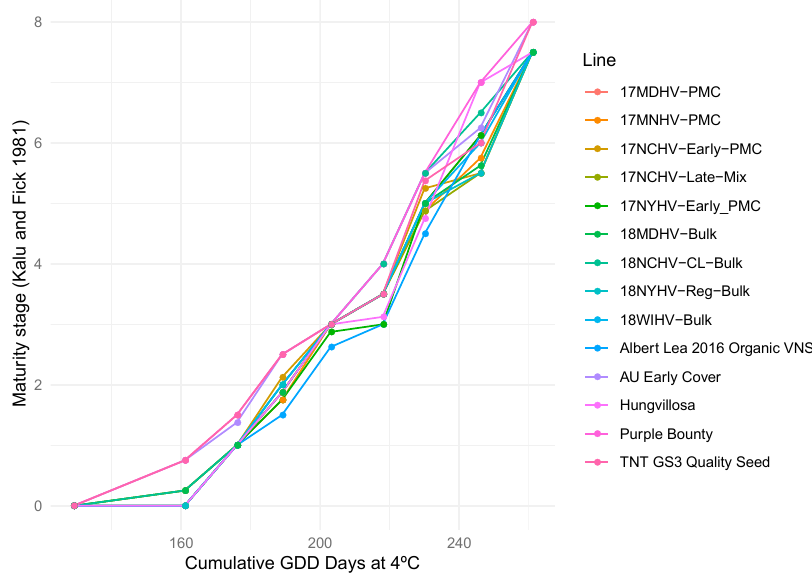
Figure A1. Maturity development time series for fourteen V. villosa lines grown at the USDA-ARS Forage Seed and Cereal Research Unit in Corvallis, Oregon in 2019. Data were collected in four replicate plots per line, each plot measuring 4.65 m 2 . Every two weeks, researchers rated the maturity of each line on a scale modified from Kalu and Fick [54]. A linear extrapolation function of the data determined the growing degree days above 4 °C (GDD) necessary to reach physiological seed maturity. In a linear model (Equation (3)), maturity stage explained 97.45% of the variance in GDD among V. villosa